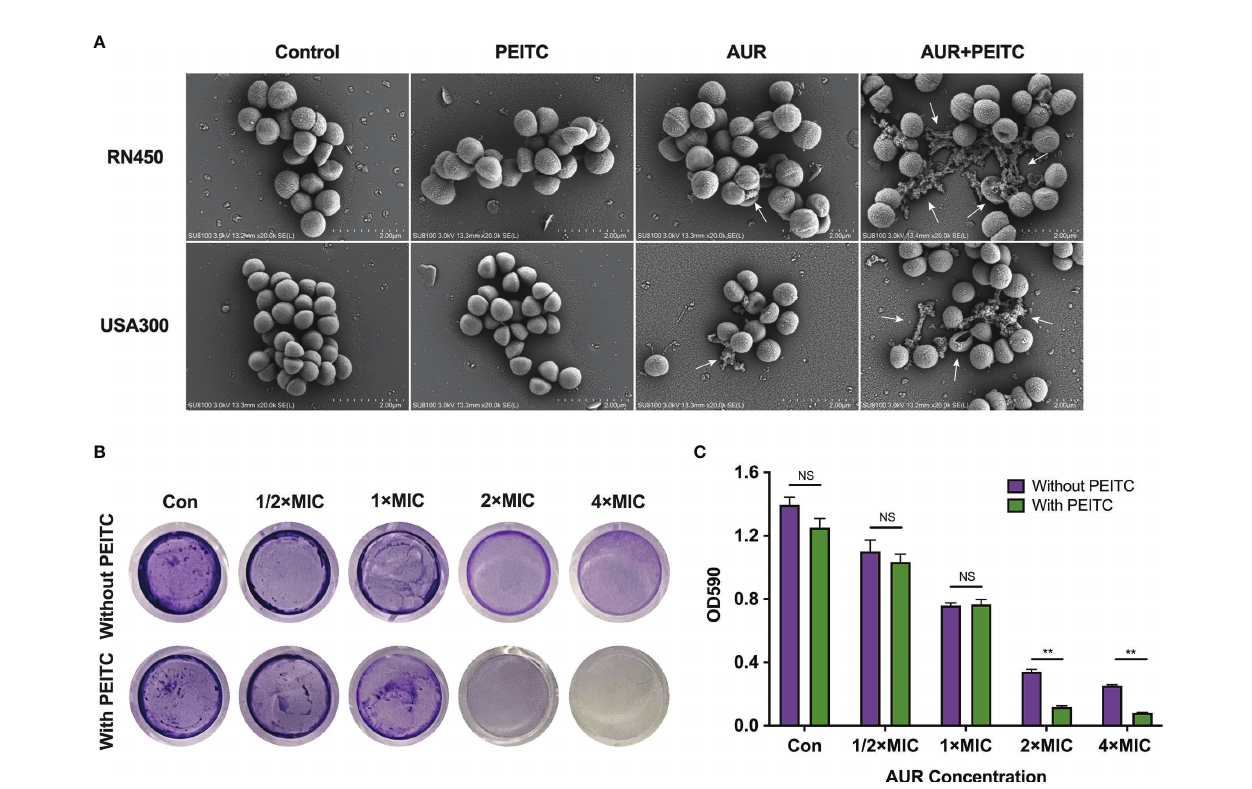
FIGURE 6 | Impact of AUR and PEITC on bacterial morphology and bio fi lm formation. (A) Scanning electron micrographs (SEM) images of S. aureus RN450 and MRSA USA300 after treatment with (4× MIC) AUR alone, (1× MIC) PEITC alone or the AUR-PEITC combination. White arrows show morphological damage in bacteria. Scale bar: 2 m m. Controls, no treatment; AUR, aurano fi n; PEITC, phenethyl isothiocyanate. (B) Crystal violet staining of RN450 bio fi lms under different treatments. Biomass quanti fi cation of bio fi lms in (C) by measurement of absorbance at 590 nm. Error bars represent standard errors of the means. **P < 0.01; NS, no signi fi